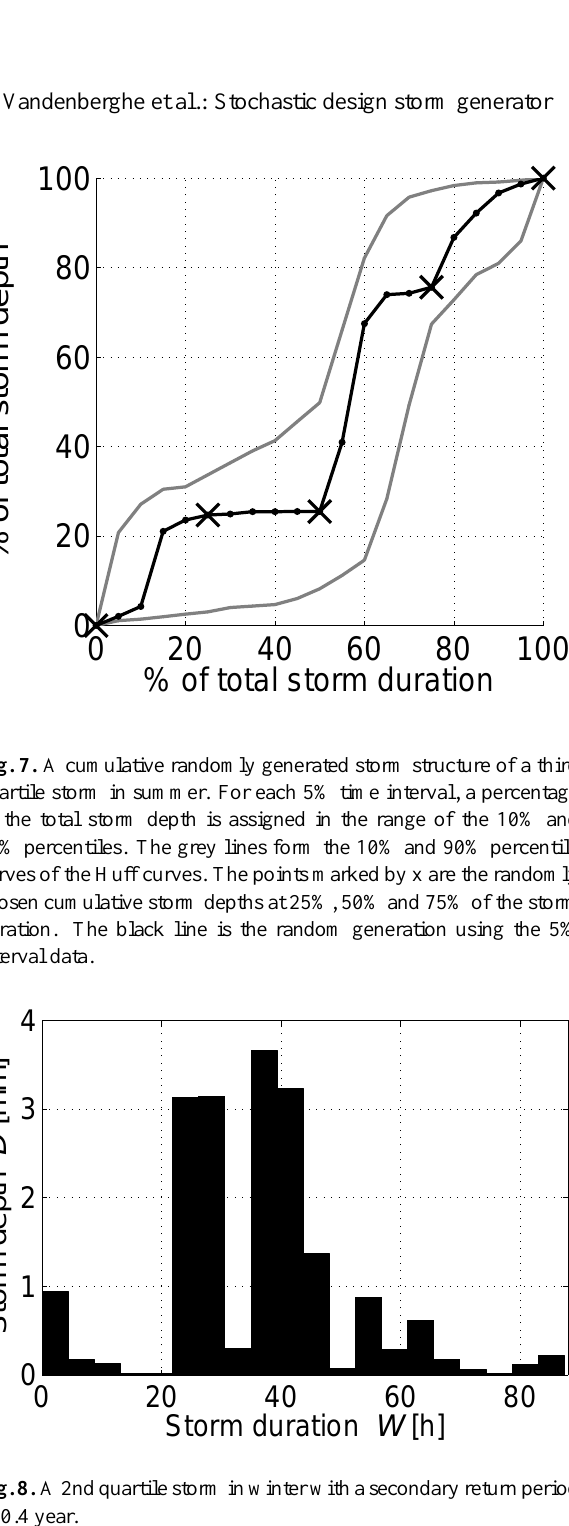
Fig. 8. A 2nd quartile storm in winter with a secondary return period of 0.4 year.